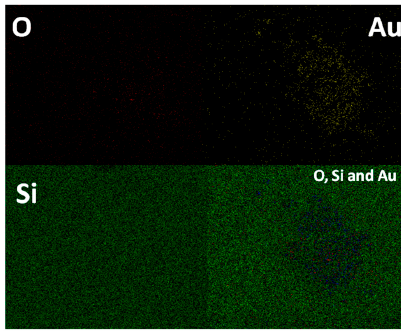
Figure 3. Scanning electron microscopy images of the thin film GSM-23F on various magnifications and the cross-sectional analysis of such a thin film .